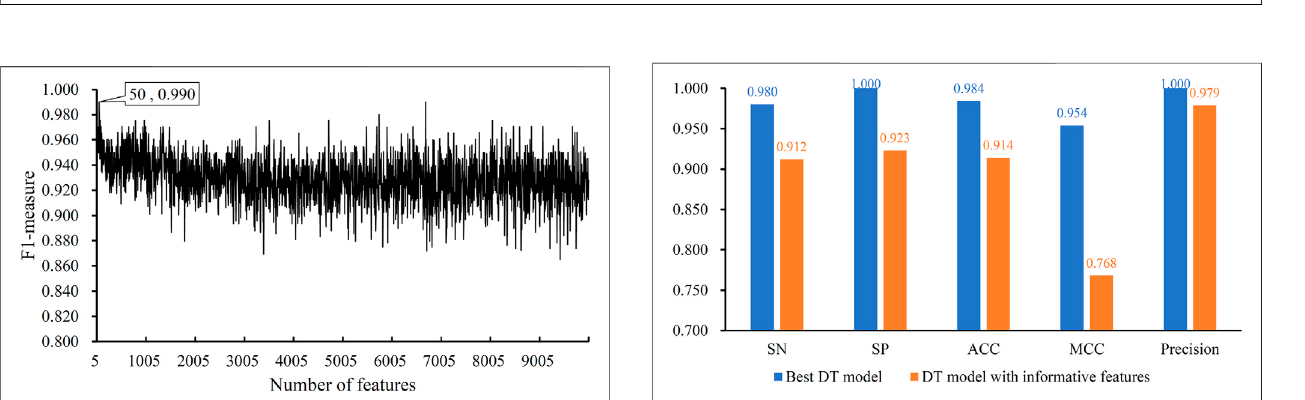
FIGURE 1 | Flowchart of the computational method in this study. A systematic analysis process that integrates feature selection, DT algorithms, and rule learning was applied to identify COVID-19 methylation site features. The optimal classi fi er, methylation sites, and rules were determined based on the performance of the DT model and the importance of the features in each model.